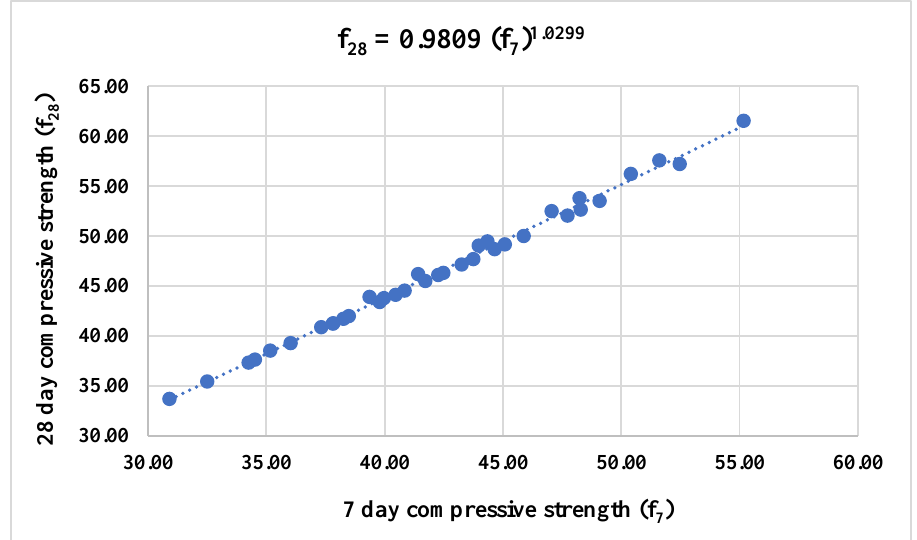
Figure 5. Relationship between 7-day and 28-day compressive strength of various design RGPC mixes.